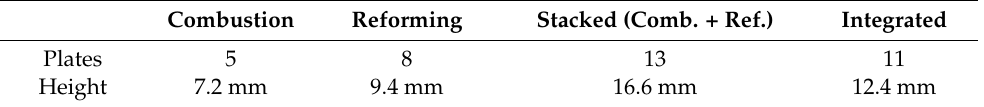
Table 1. Height and number of plates of single and combined modules.